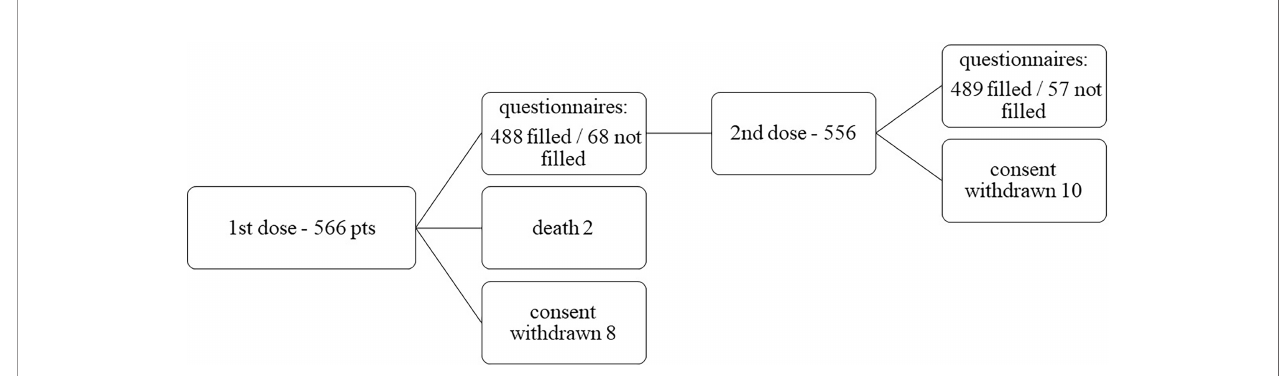
FIGURE 1 | Patients ’ disposition.